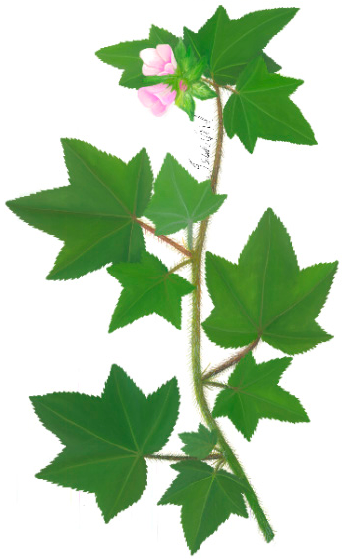
Figure 8. Malachra helodes Mart. ex Ledeb. & Alderstam.